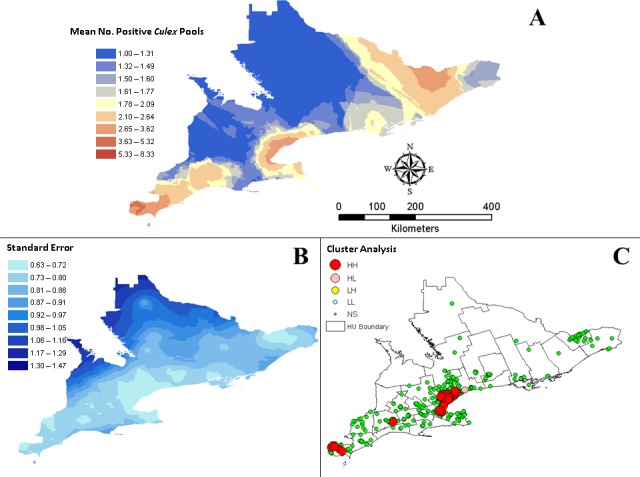
Geospatial analysis of WNV positive Culex mosquito pools in Ontario, Canada from 2002 to 2013.(A) Predicted mean number of positive Culex mosquito pools. (B) Standard error of predicted mean number of positive Culex pools. (C) LISA cluster analysis of WNV positive light traps recorded in Ontario during 2002 to 2013. LISA cluster analysis revealed both significant HH (local Moran’s index > 0, p < 0.05) and HL (local Moran’s index < 0, p < 0.05) trap locations (p < 0.05) as well as non-significant (NS, p > 0.05) trap locations (n = 680).